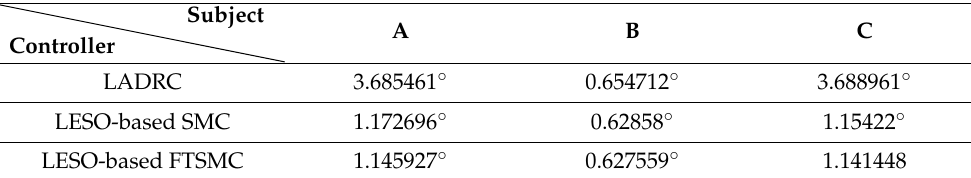
Table 2. RMSE of different subjects’ hip joint trajectories for LADRC, LESO-based SMC, and LESO- based FTSMC.